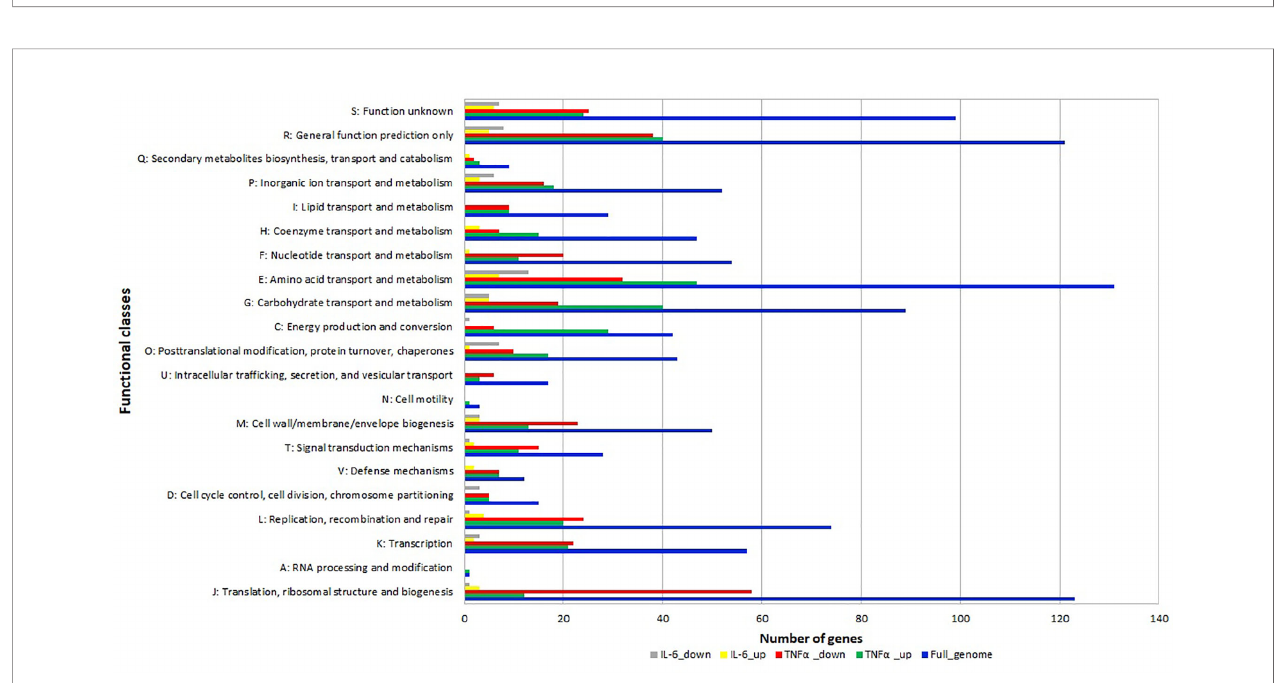
FIGURE 4 | Relative abundance of transcripts grouped into Clusters of Orthologous Groups (COG) functional categories. Functional classi fi cation of genes with statistically signi fi cant increase (green bar for TNF a and yellow bar for IL-6) or decrease (red bar for TNF a and gray bar for IL-6) in mRNA level compared to